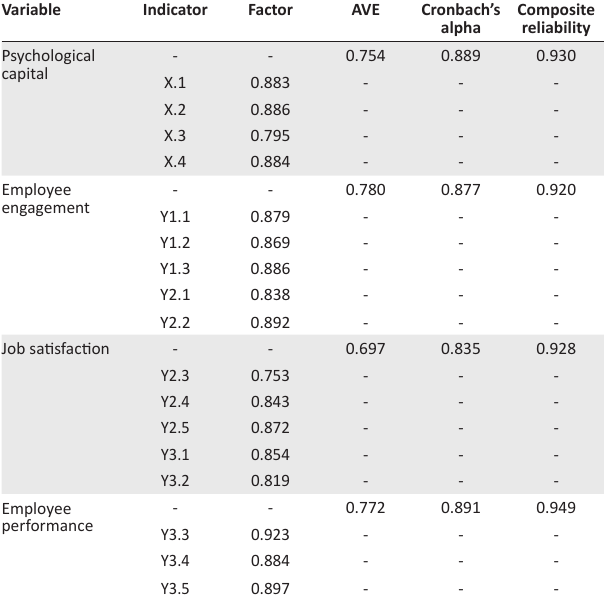
TABLE 2: Items description, internal reliability, composite reliability and convergent validity.